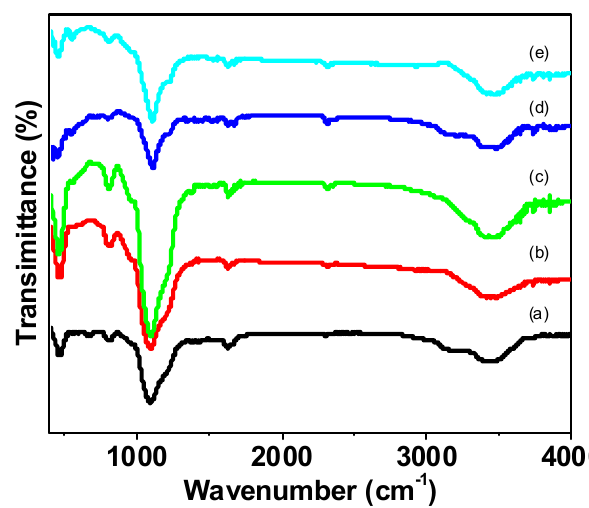
Figure 2. FT-IR spectra of ( a ) NM-ZSM-5-0h, ( b ) NM-ZSM-5-4h, ( c ) NM-ZSM-5-8h, ( d ) NM-ZSM-5-16h, and ( e ) NM-ZSM-5-24h.